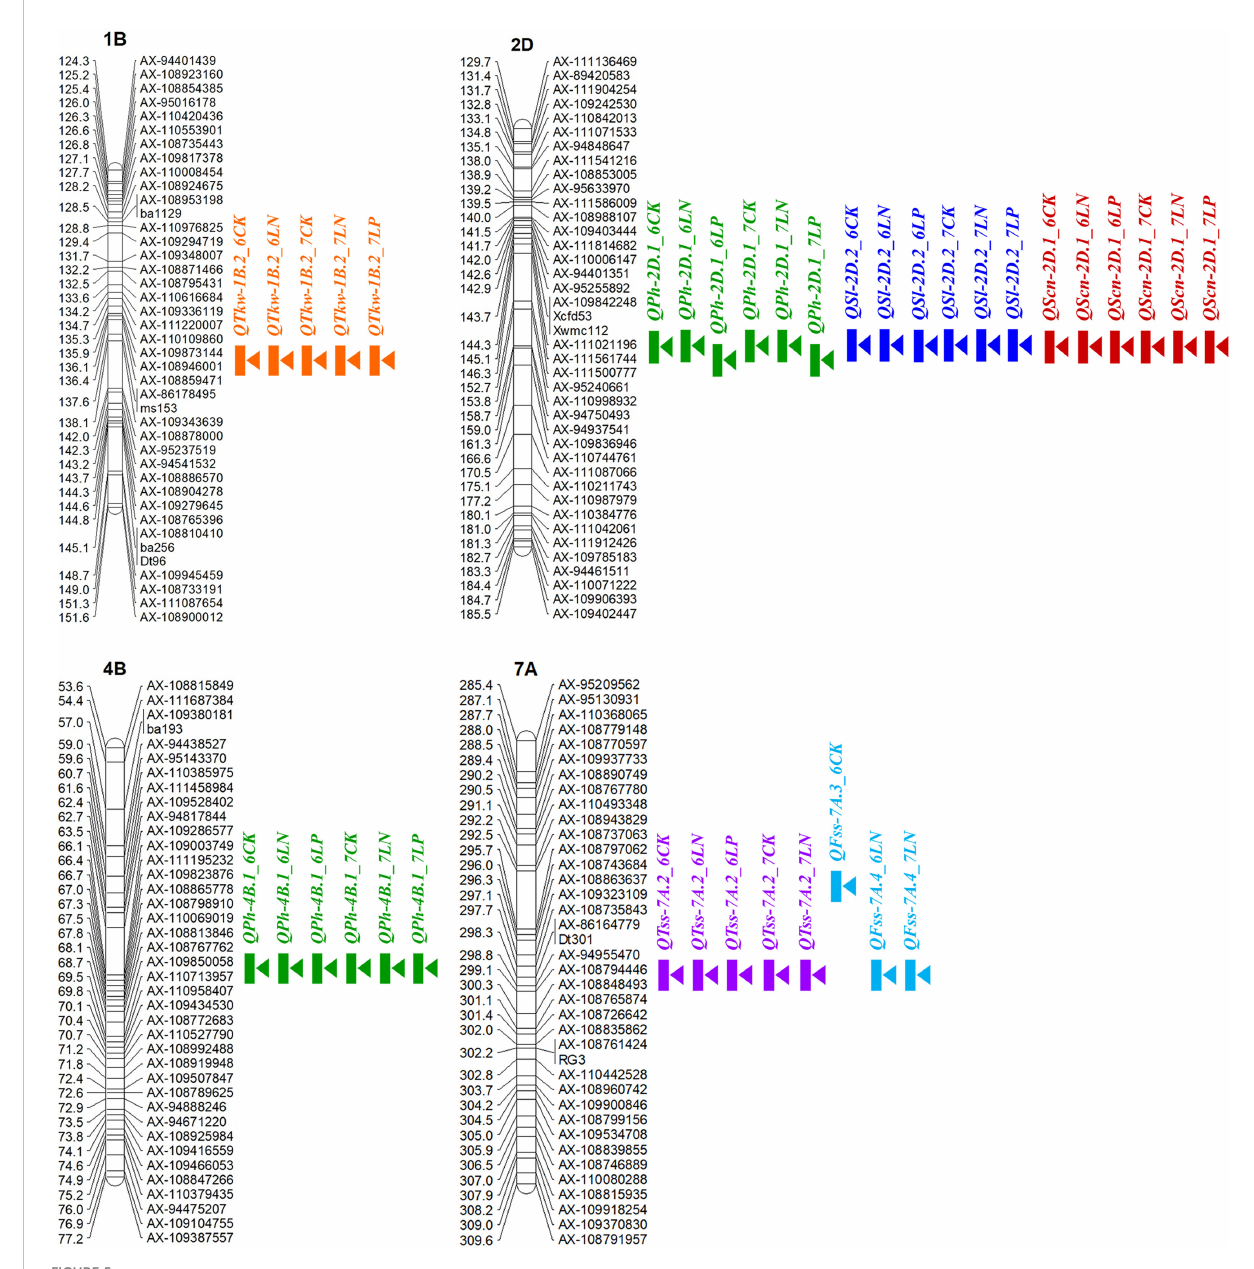
FIGURE 5 Locations of the four environmentally stable QTLs for yield-related traits in at least fi ve environments. The short arms of the chromosomes are located at the top. The names of the marker loci and the QTL are listed on the right side of the corresponding chromosomes. The positions of the marker loci are listed on the left side of the corresponding